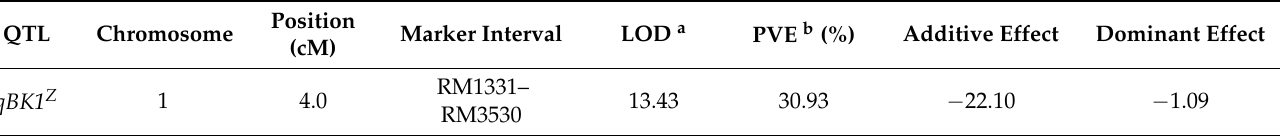
Table 1. Putative quantitative trait locus (QTL) associated with bakanae disease resistance detected at the seedling stage by composite interval mapping of the 180 F 2:9 populations derived from a cross between Ilpum and Zenith. Position QTL Chromosome Marker Interval LOD a PVE b (%) Additive Effect Dominant Effect (cM) RM1331– qBK1 Z 1 4.0 RM3530